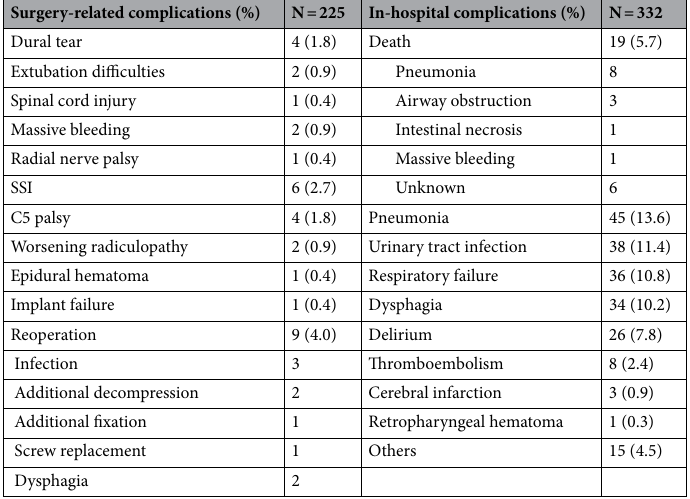
Surgery-related complications (%) N = 225 In-hospital complications (%) N =